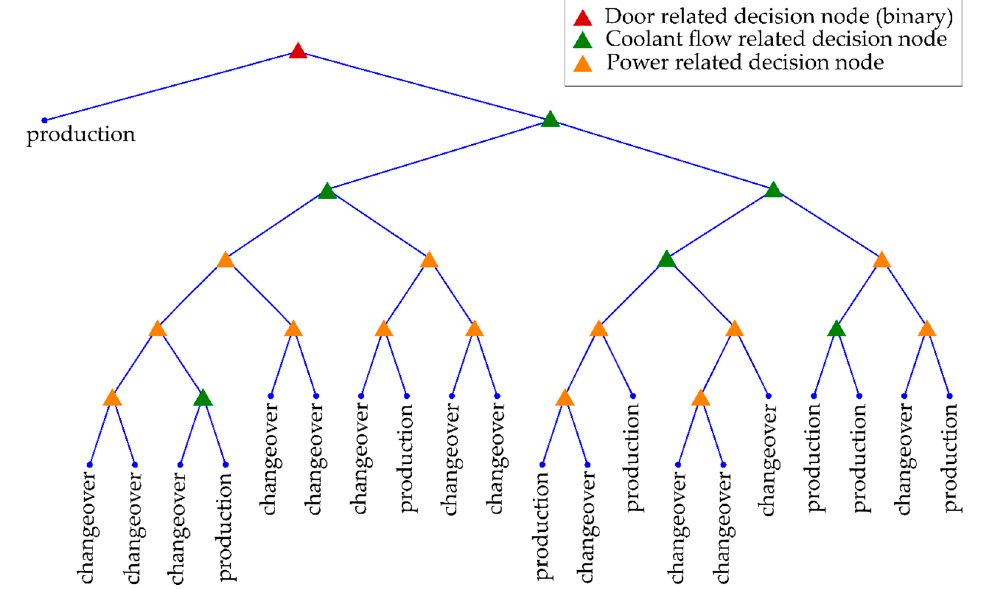
Figure 7. Exemplary RUS Boosted Tree.